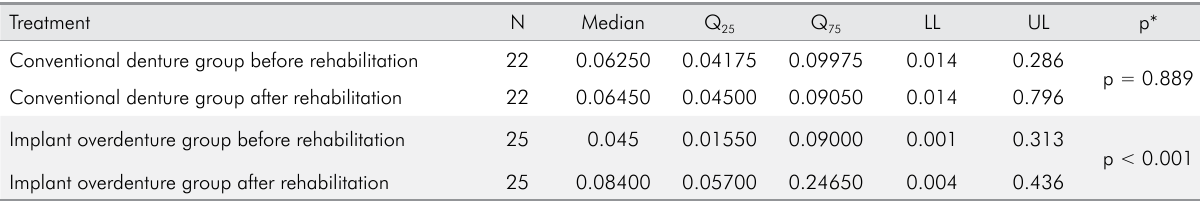
Table 2. Masticatory efficiency before and after three months of rehabilitation. Treatment